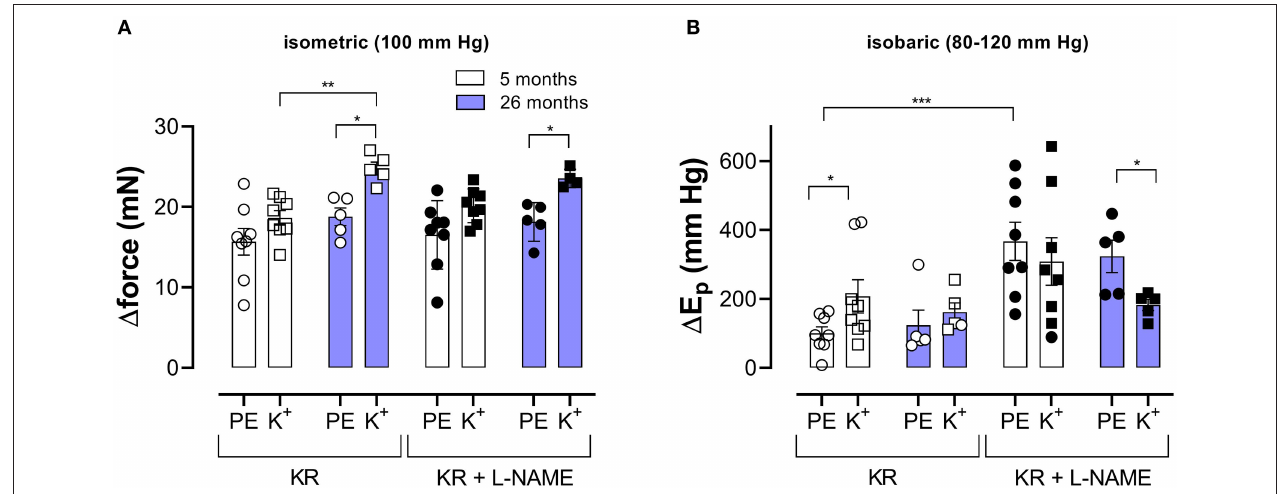
FIGURE 4 | α 1 -Adrenergic stimulation and maximal depolarization of aortic segments cause different isometric and isobaric effects. Aortic segments were mounted in isometric (100mm Hg, A ) and isobaric (80–120mm Hg, B ) conditions and treated with 2 µ M PE (circles) or depolarized with 50mM K + (squares) in the absence (open symbols) and presence (closed symbols) of 300- µ M L-NAME. The increase of force ( 1 orce) and E p ( 1 E p ) was determined in aortic segments of 5 (white bars) and 26 (blue bars) months old mice. Two-way RM ANOVA with Sidak’s multiple comparison test. * p < 0.05, ** p < 0.01, and *** p <